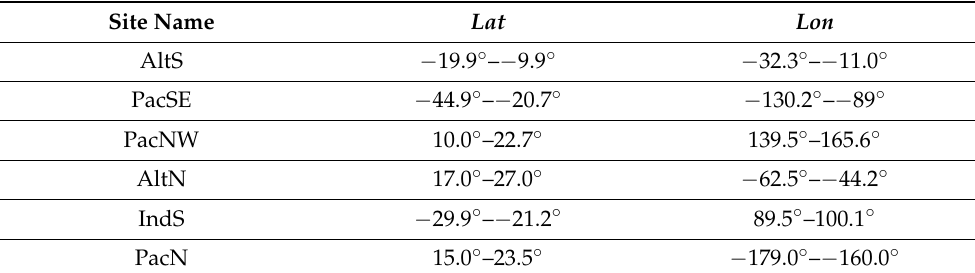
Table 3. The locations of the SNESs selected in our